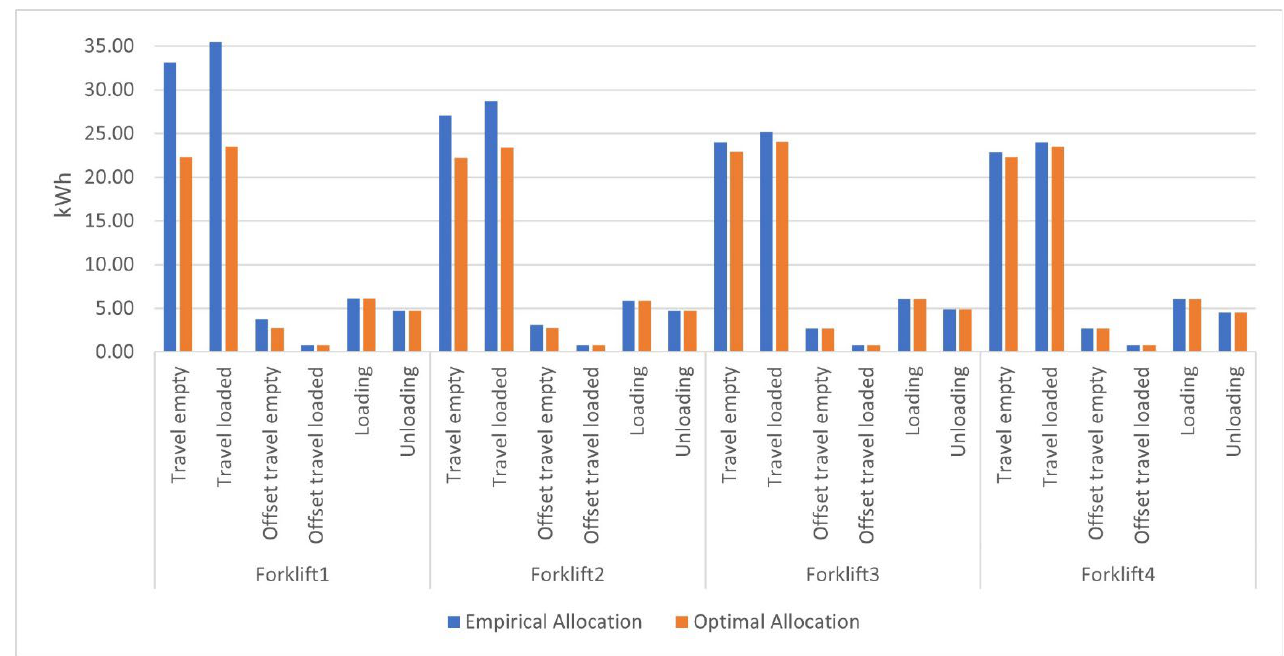
Figure 5. Energy consumption of the forklifts in two scenarios.